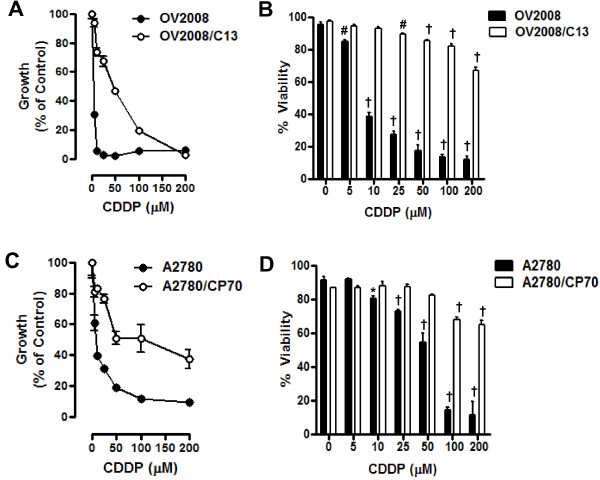
Growth inhibition and lethality of cisplatin towards OV2008, OV2008/C13, A2780 and A2780/CP70 cells. Cells were cultured in the presence of the indicated concentrations of cisplatin for 1 h and maintained in cisplatin-free medium for 3 days. (A) and (C), the total number of cells was recorded at the beginning of the experiment and after 3 days of treatment. The difference between number of cells in vehicle-treated controls at 0 h and after 3 days of culture was considered to be 100%. The growth of the treated groups is expressed as percentage of control. The experiment was repeated three times with different cell line passages to calculate the IC50 (see averaged data on Table 1). Depicted are representative experiments. (B) and (D), after treatment, viability was assessed by microcapillary cytometry. Results are the average of triplicate counts ± SEM. *p < 0.05, #p < 0.01 and †p < 0.001 vs. control (0 μM cisplatin) for the respective cell line.